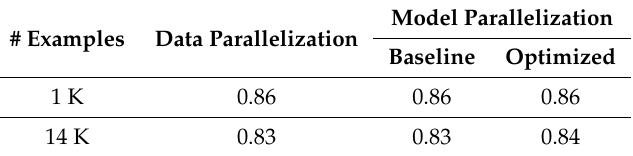
Table 5. Accuracy comparison between data parallelization and each one of our proposed model parallelization